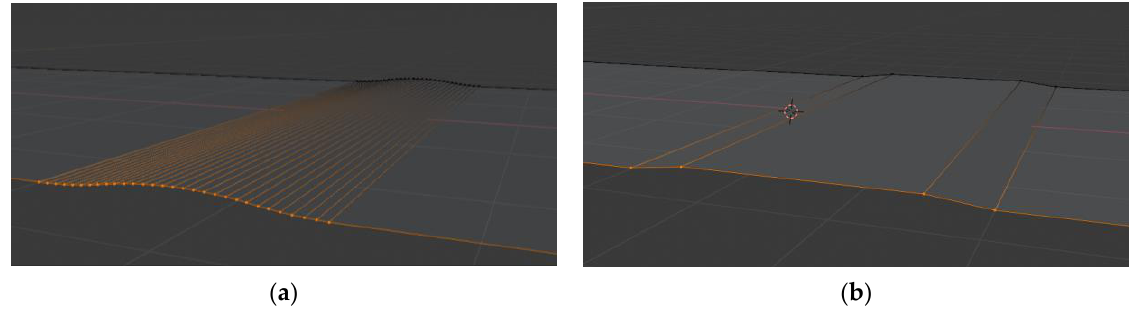
Figure 18. The models of the profiles selected made in program Blender: ( a ) speed bump A, ( b ) speed bump B. These models were made in two stages—first they were made by rectangles and then triangularization was performed. An example of profile B after triangularization is presented in Figure 19.